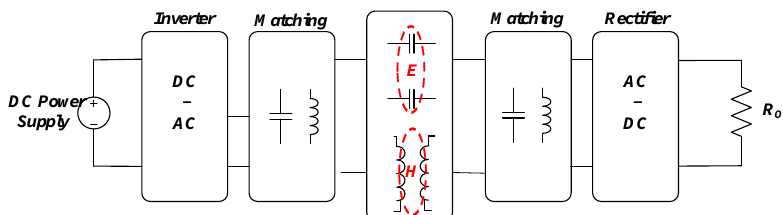
Figure 1. Simple structure of wireless power transfer system with magnetic and electric coupling [1].